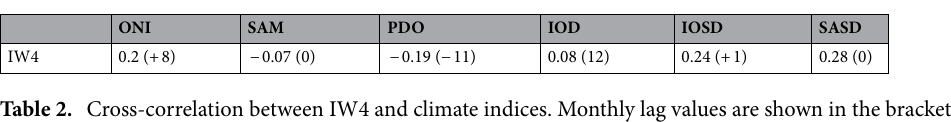
Table 2. Cross-correlation between IW4 and climate indices. Monthly lag values are shown in the bracket (positive (negative) lag corresponds to the leading (lagging) of IW4 with the climate indices).